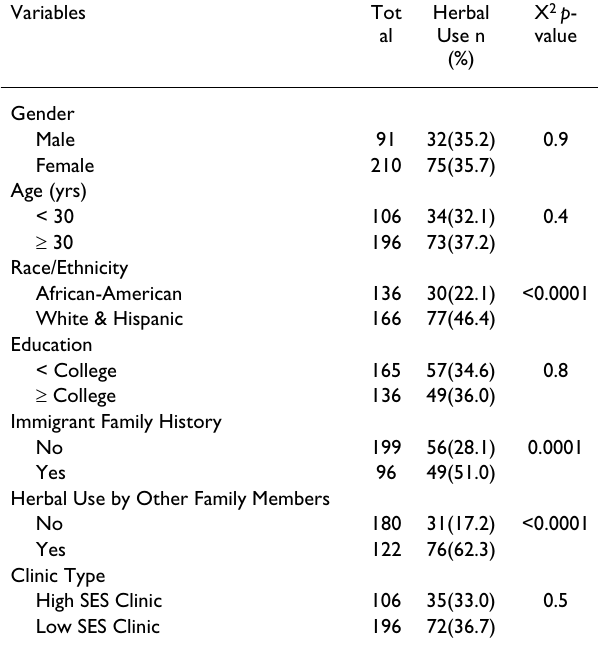
Asians reported the highest rates of herbal use (50%), and Table 3: Univariate Analysis of Factors Associated with Herbal